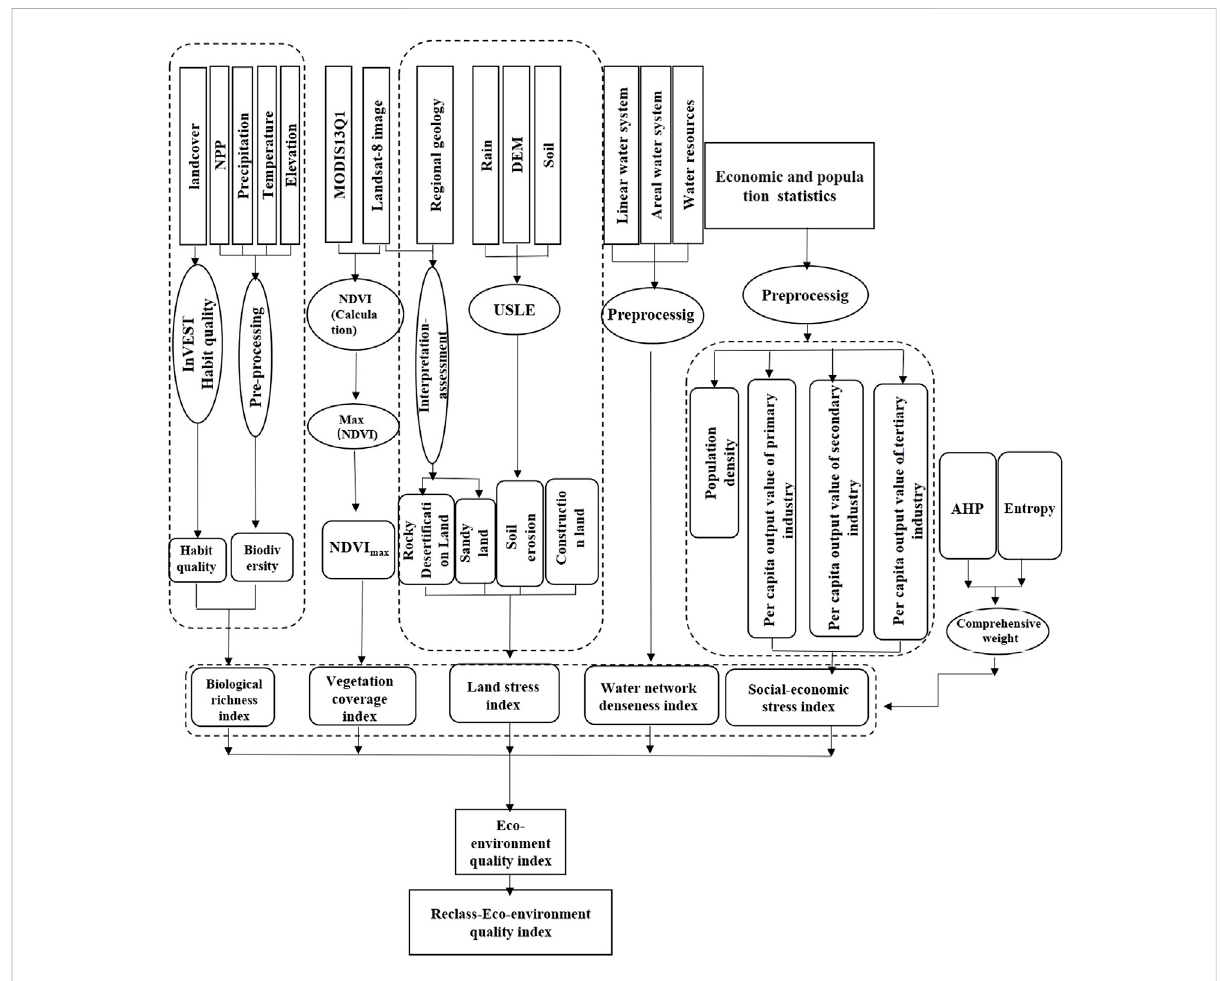
FIGURE 3 Technical processes of estimating EQI based on multisource